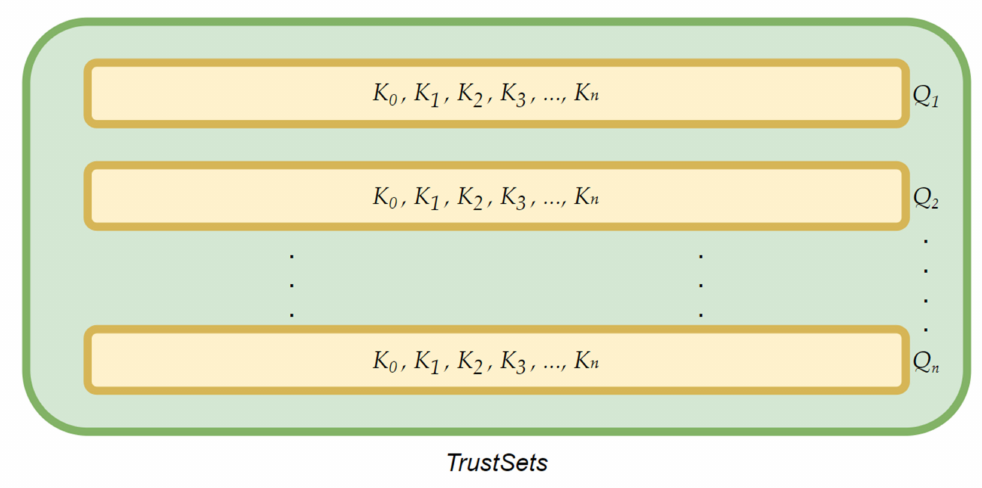
Figure 6. Representation of storage of trust